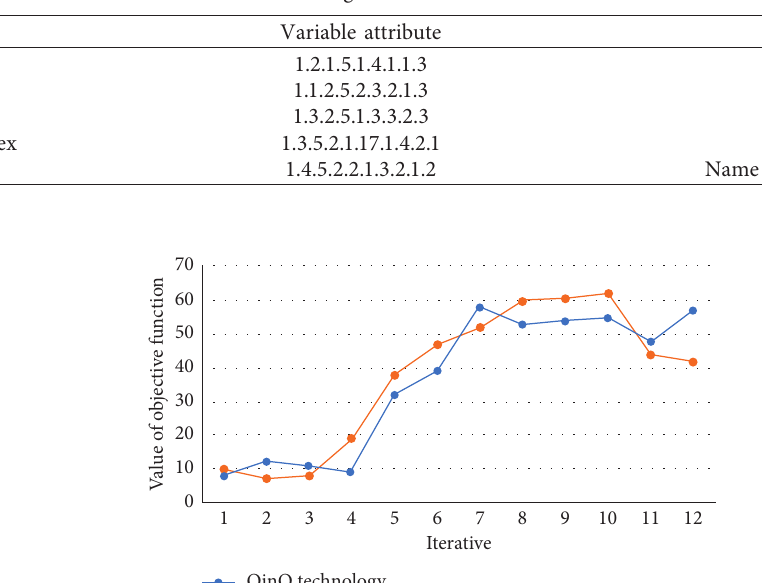
Table 2: Management information base variable.